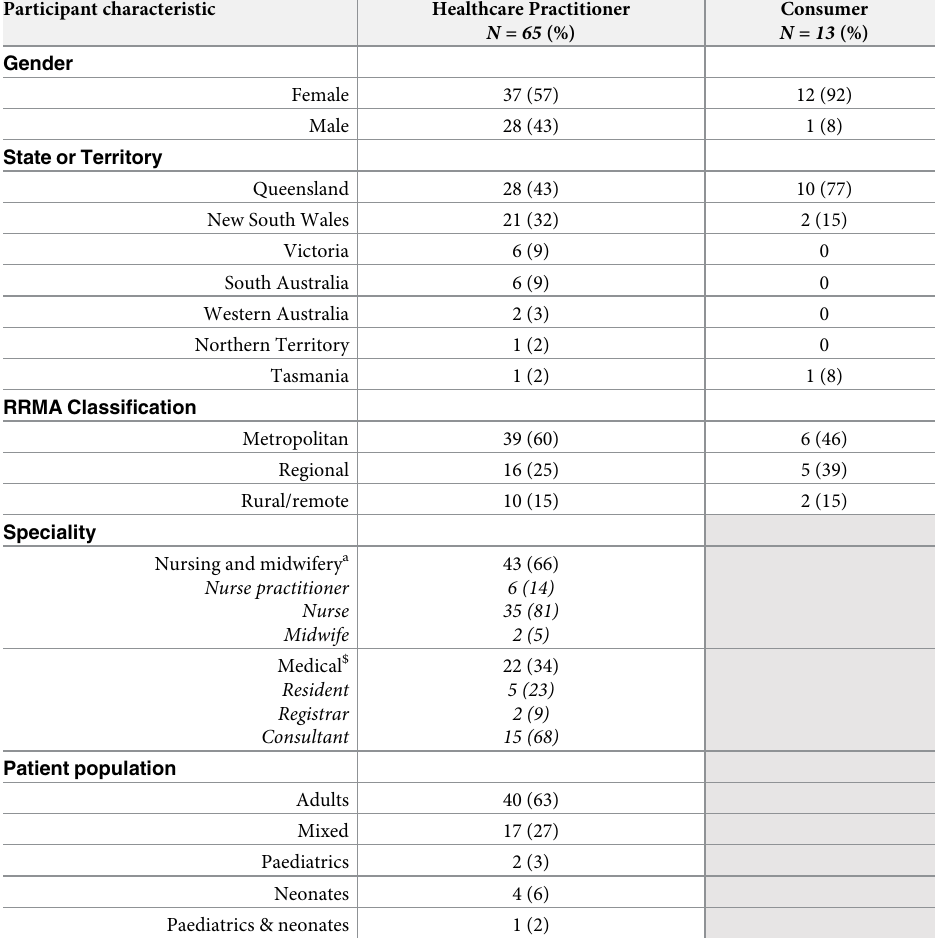
Table 1. Summary of participant characteristics (N = 78).